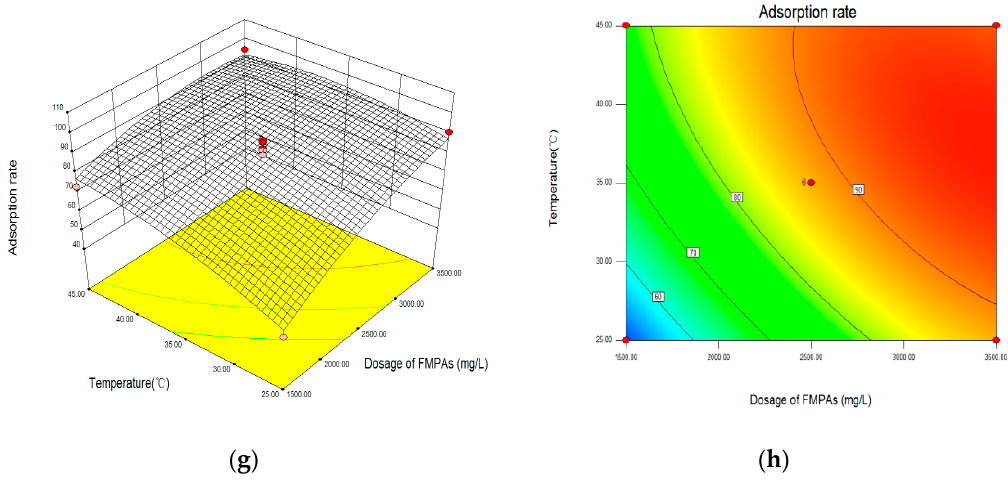
Figure 1. The 3D surface and contour. ( a , b ): Sb(III) Temperature, Adsorption time and Adsorption rate, ( c , d ): Sb(III) Initial concentration, Dosage of FMPAs and Adsorption rate, ( e , f ): Sb(III) Initial concentration, Temperature and Adsorption rate, ( g , h ): Sb(III) Temperature, Dosage of FMPAs and adsorption rate.